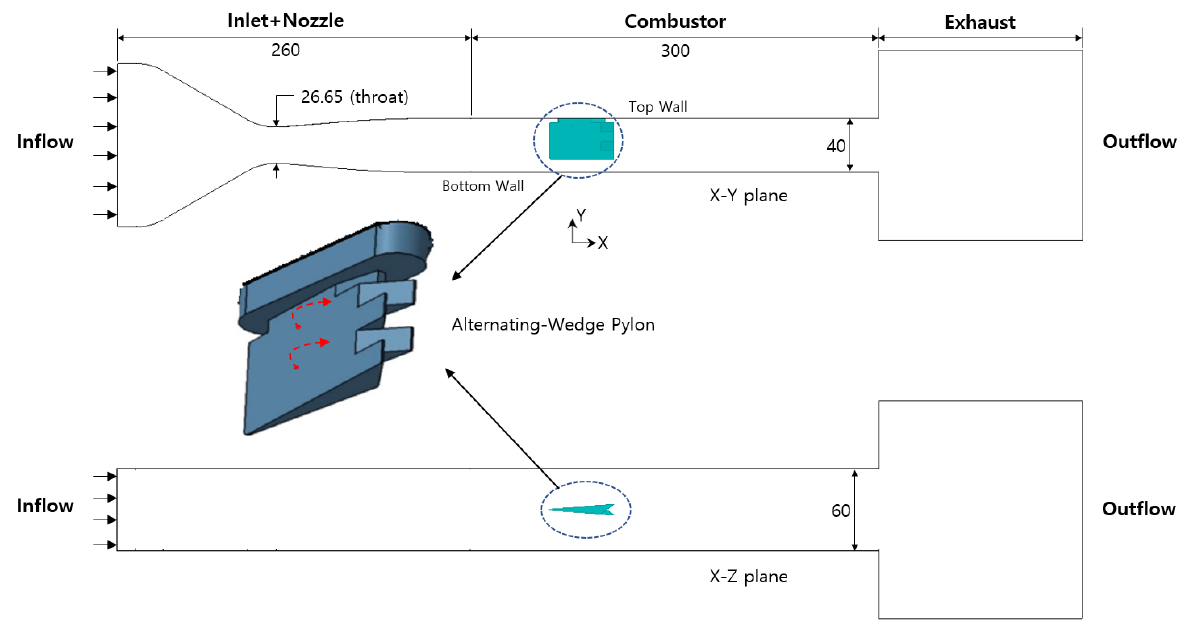
Figure 1. Schematic diagram of the computational domain including the alternating-wedge pylon (all units in mm).